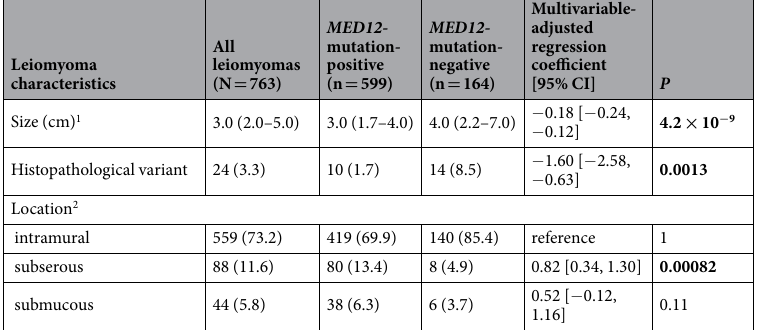
Table 2. Leiomyoma characteristics and results of the generalised estimating equations model including leiomyoma size, location and histotype (n = 683). Data are median (inter quartile range) or n (%) unless otherwise specified. To adjust for multiple comparisons, P < 0.00147 indicated statistical significance (the Bonferroni correction). CI = confidence interval. 1 15 missing values: 13 mutation-positive and 2 –negative. 2 72 missing values: 62 mutation-positive and 10